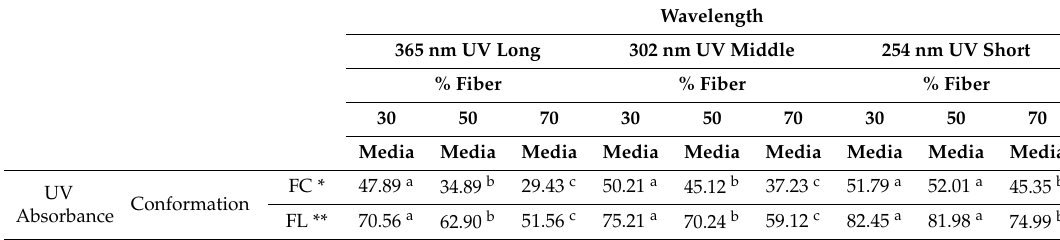
Table 6. UV absorbance after exposure to di ff erent wavelengths of di ff erent LBMs with the di ff erent concentrations (30, 50 and 70%). Wavelength 365 nm UV Long 302 nm UV Middle 254 nm UV